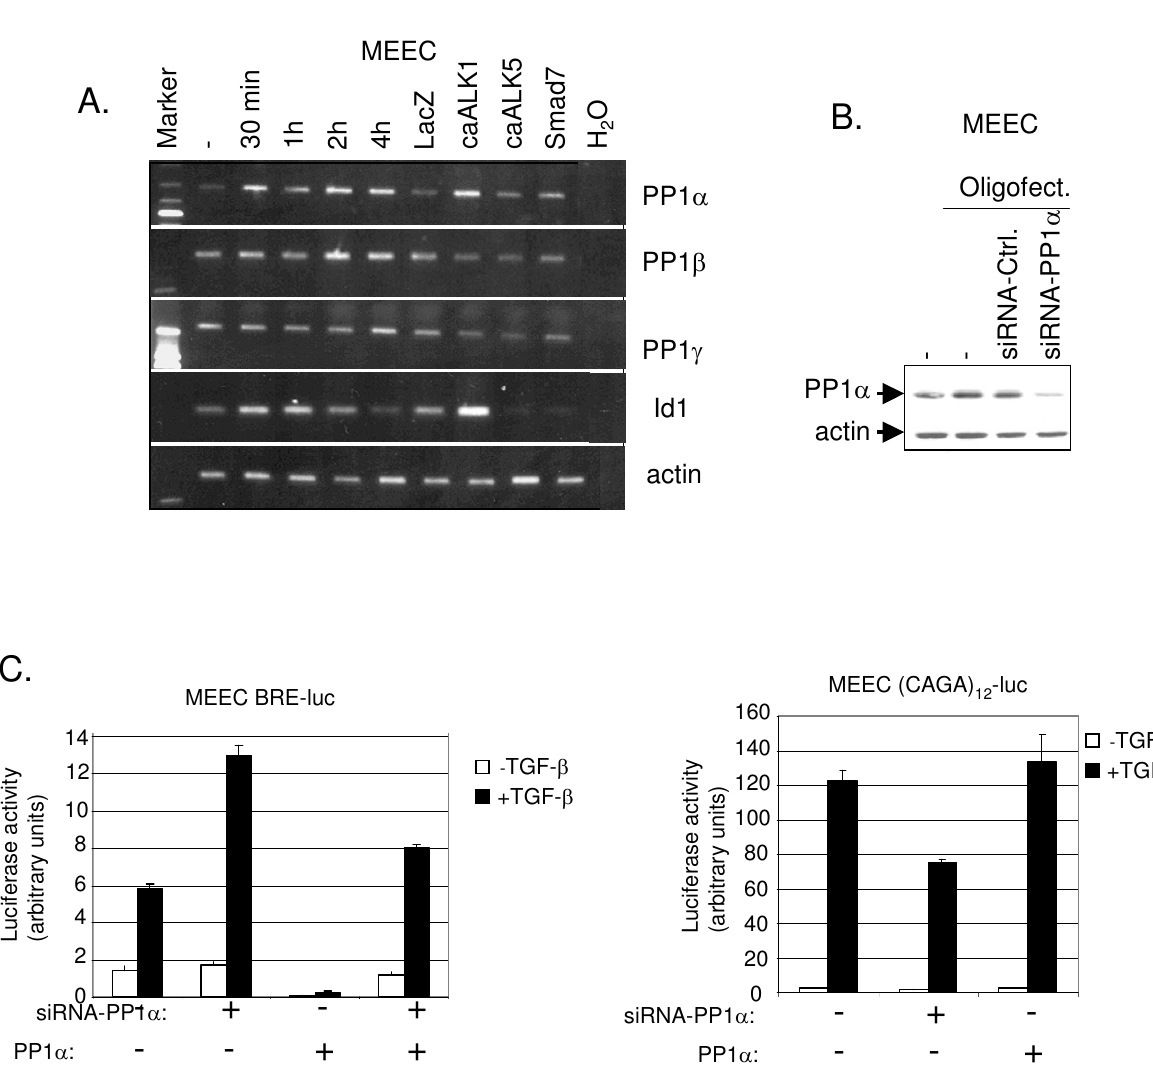
triplicate samples is shown. Right panel . MEECs were transfected with (CAGA) incubated with TGF- β for an additional 16 h, whereafter luciferase activity was measured. Values are corrected for transfection efficiency as measured by β -galactosidase activity. A representative experiment using